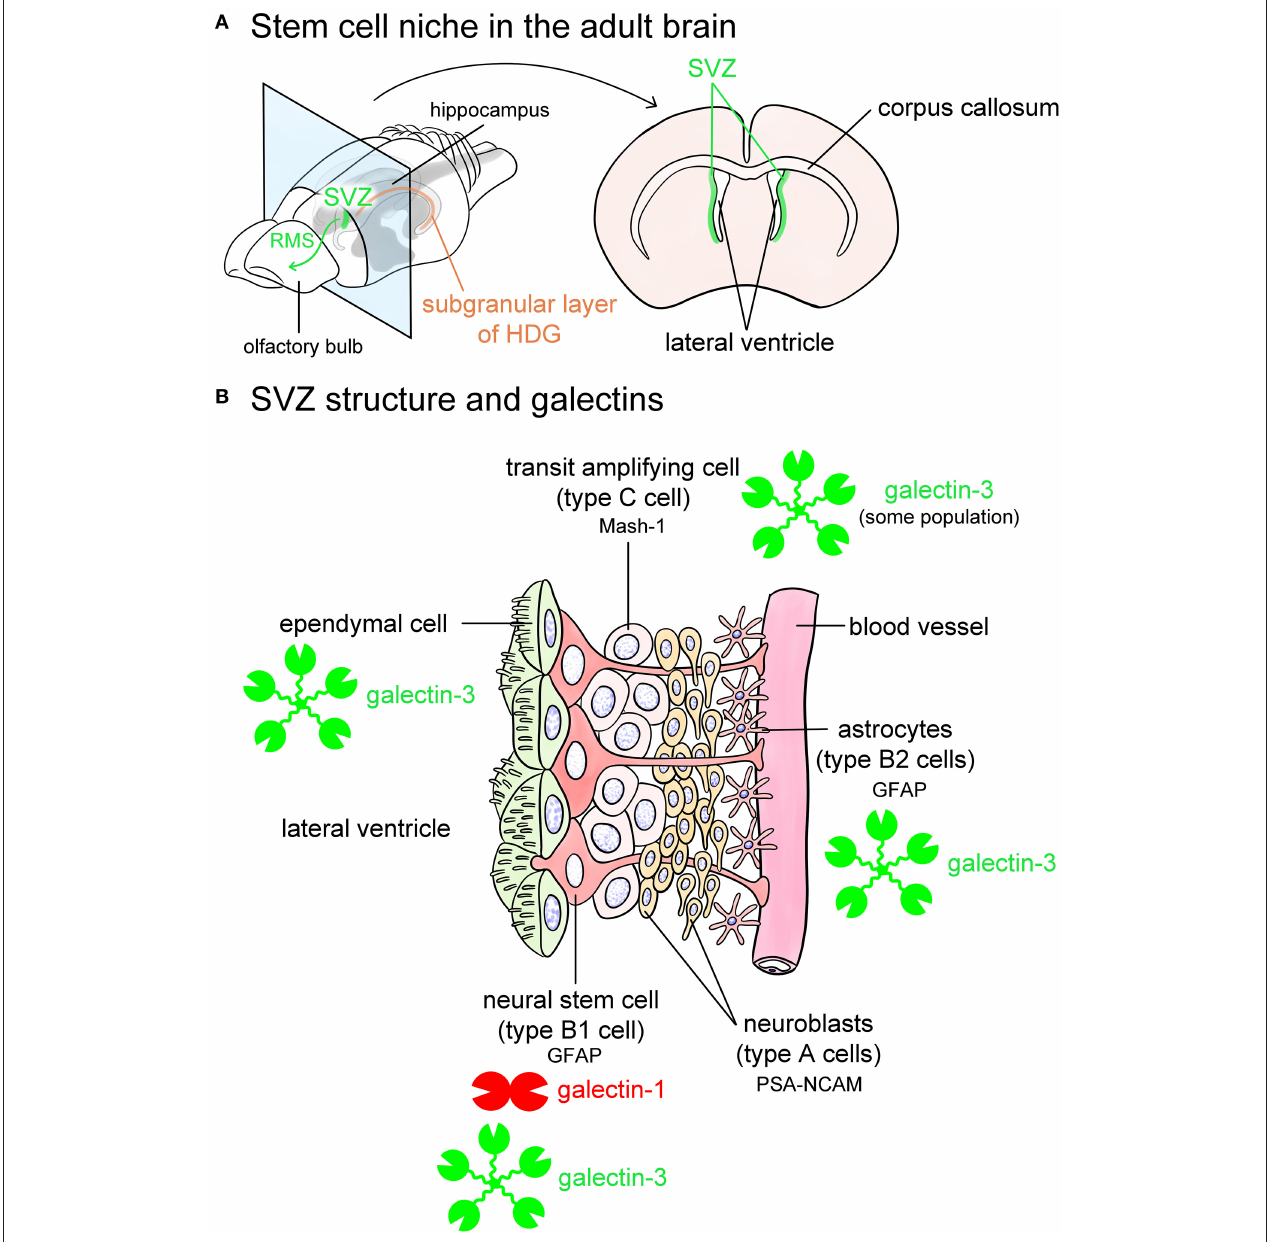
FIGURE 5 | Galectins in the stem cell niches. Known stem cell niches in the adult brain are the subventricular zone (SVZ) (green in A ) and subgranular layer of hippocampal dentate gyrus (HDG) (orange in A ). The SVZ is located in the lateral wall of the lateral ventricles in the adult mouse brain (A) . Newly produced neurons in the SVZ migrate through rostral migratory stream (RMS) to the olfactory bulb (green arrow in A ) at where they differentiate into interneurons such as periglomerular cells and granule cells, and also migrate to damaged lesions. The SVZ beneath ependymal cells is composed of glial fibrillary acidic protein (GFAP)-positive astrocytic neural stem cells (type B1 cells), astrocytes (type B2 cells) located along the blood vessels, mammalian achaete-scute homolog 1 (Mash-1)-positive transit amplifying cells (type C cells), and neuroblasts (type A cells) (B) . Type B1 neural stem cells express galectin-1, and possibly galectin-3. Some population of type C cells contains galectin-3 (B) . Galectin-3 is also abundant in ependymal cells and type B2 astrocytes (B) . Based on the researches by Sakaguchi et al. (2006), Comte et al. (2011), and Pasquini et al. (2011). PSA-NCAM, polysialylated form of neural cell adhesion molecule.